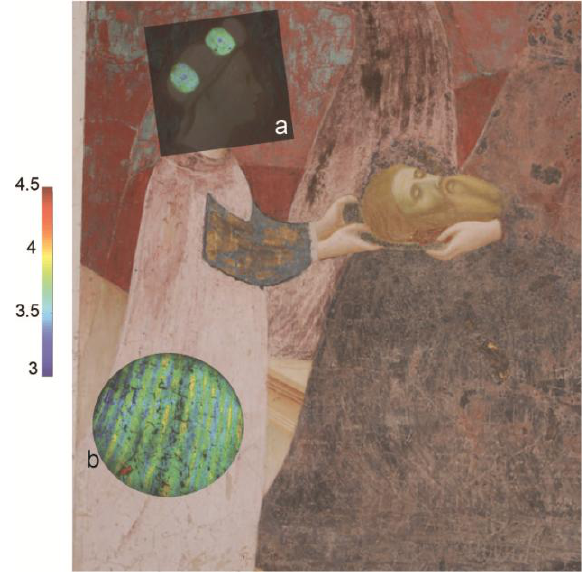
Figure 5. FLIM analysis of the wall painting of the Life of John the Baptist (Colleggiata, Castiglione Olona, Varese, Italy) by Masolino: the fluorescence lifetime maps taken from the figure of Salome were superimposed on the color image. In the ovals of the headdress ( a ) and in the vest ( b ) areas with different lifetimes can be discriminated, which are related to a different content of red